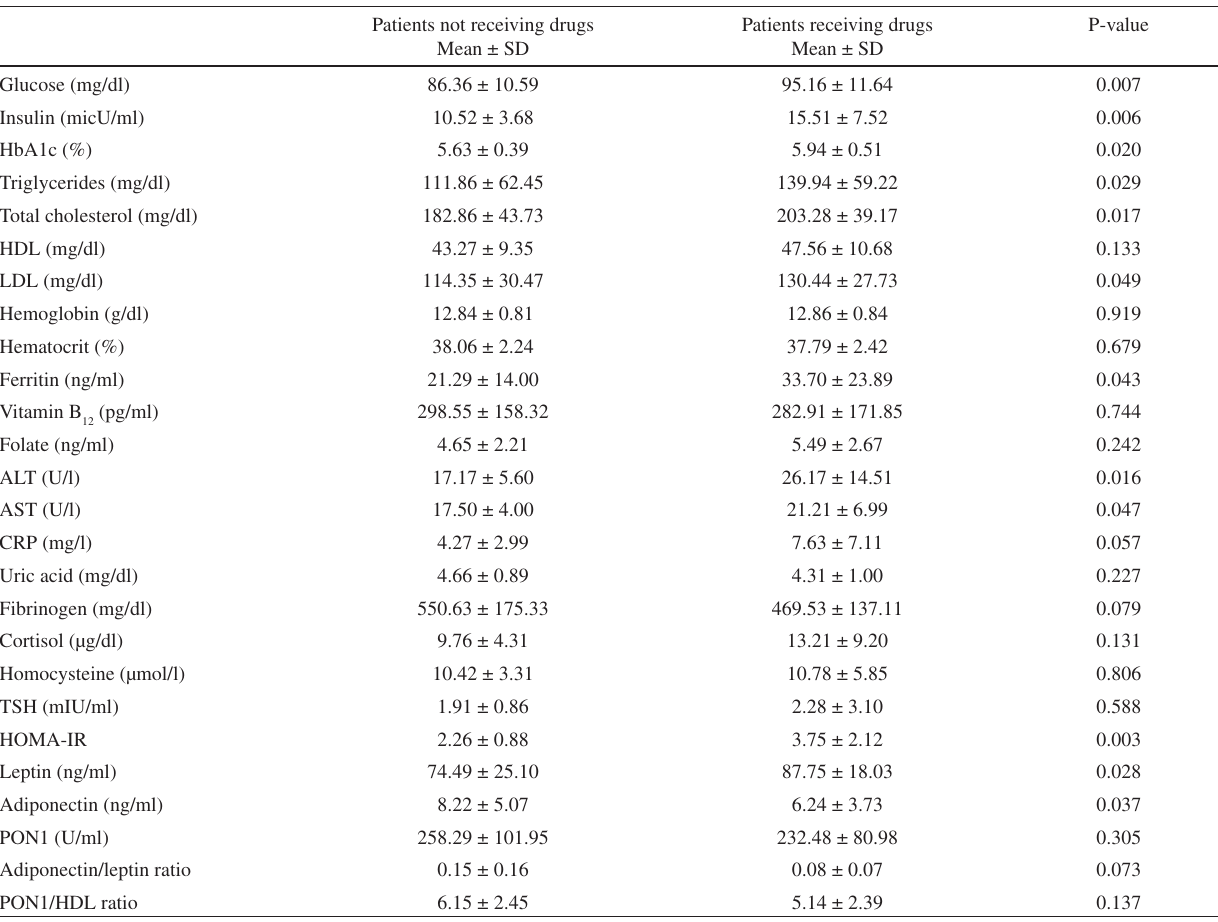
Table 2 - Comparison of biochemical findings between groups